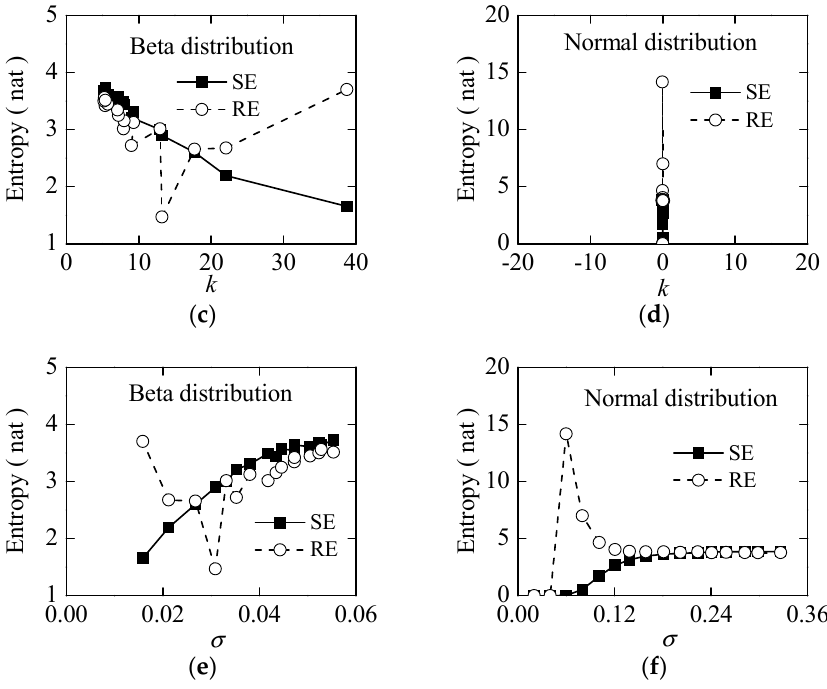
Figure 3. Renyi entropy (RE) and Shannon entropy (SE) as a function of the distribution parameters of: ( a , b ) γ ; ( c , d ) κ ; and ( e , f ) σ , for: ( a , c , e ) Beta distribution, a = 20; b = 0.1,0.1, · · · ,1.6; and ( b , d , f ) Normal distribution, µ = 30; σ = 0.02,0.04, · · ·